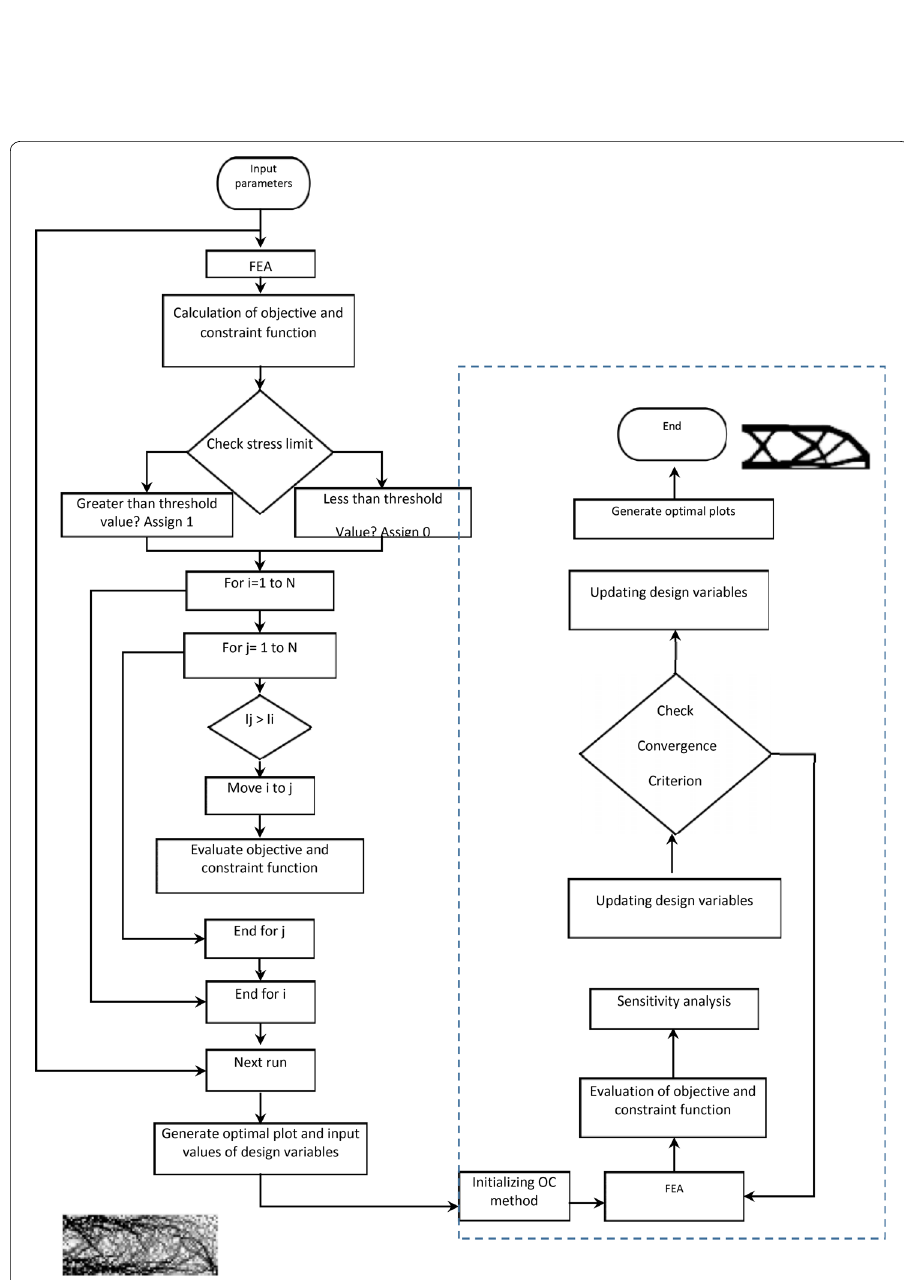
Fig. 9 A schematic diagram of structural topology optimization using discrete